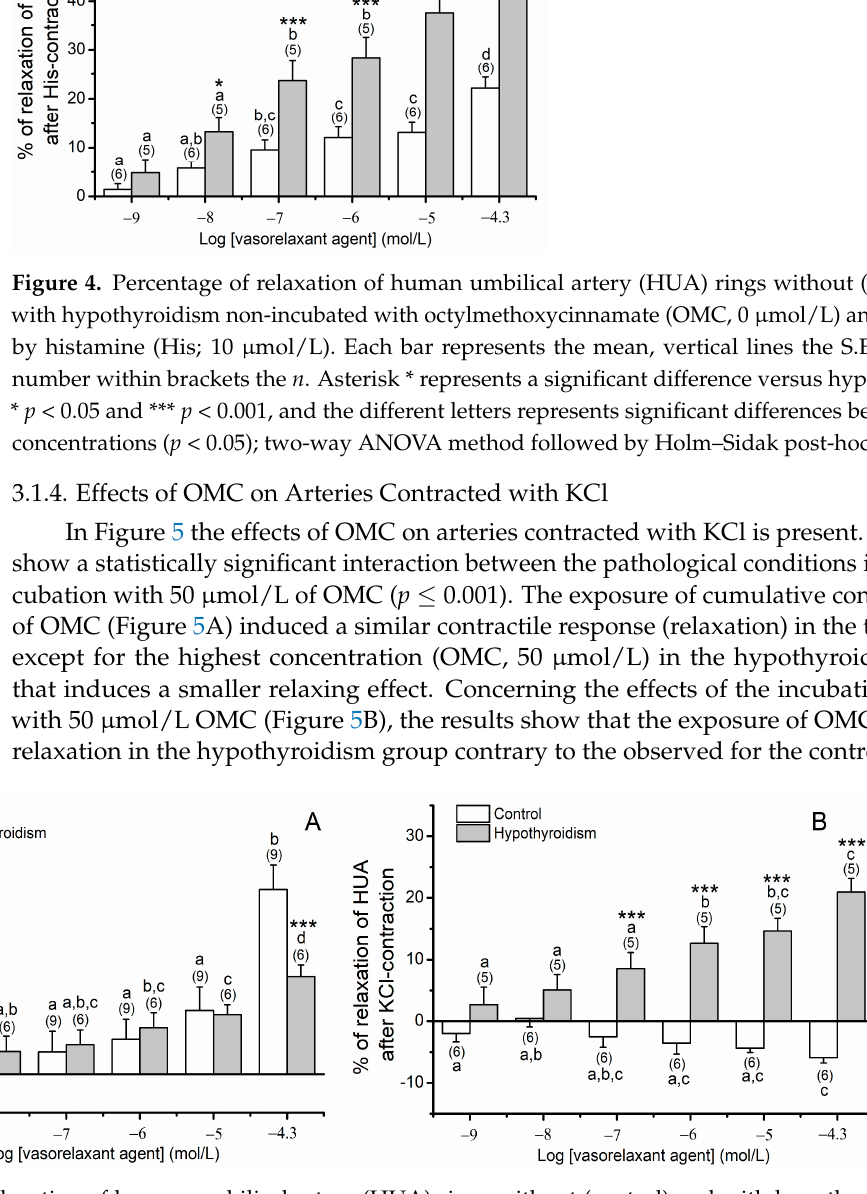
Figure 3. Percentage of relaxation of human umbilical artery (HUA) rings without (control) and with hypothyroidism incubated with ( A ) 0 µmol/L and ( B ) 50 µmol/L of octylmethoxycinnamate (OMC) and contracted by serotonin (5-HT; 1 µmol/L). Each bar represents the mean, vertical lines the S.E.M. and the number within brackets the n . Asterisk * represents a significant difference versus hypothyroidism: * p < 0.05 and *** p < 0.001, and the different letters represents significant differences between OMC concentrations ( p < 0.05); two-way ANOVA method followed by Holm–Sidak post-hoc tests.